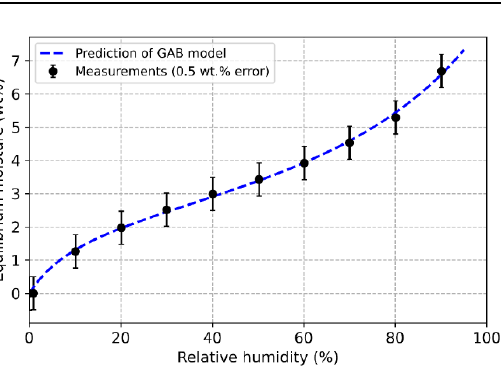
Figure 1. Desorption data for the placebo formulation measured under 40